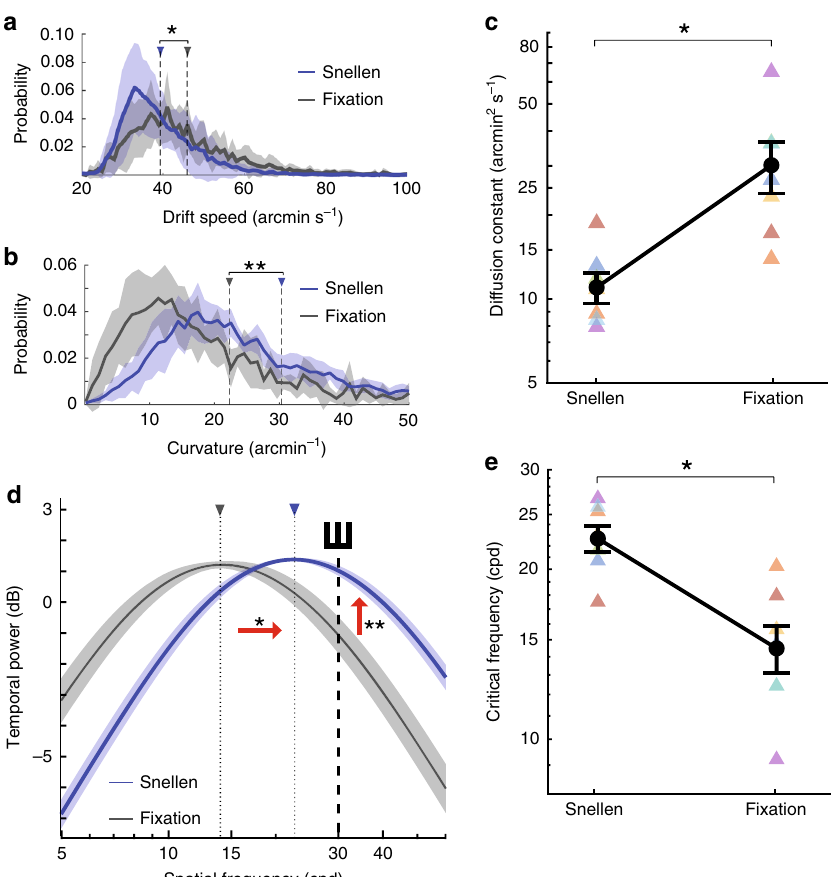
Fig. 2 Drift characteristics. Comparison of oculomotor data collected in the Snellen test and during sustained fi xation. Data represent averages and SEM across N = 7 subjects. a , b Mean distributions of a drift speed and b curvature in the two conditions. Dashed lines indicate the means of the distributions (* p = 0.047, ** p = 0.031, two-tailed Wilcoxon signed-rank test). c Average constants of drift diffusion, D , in the two conditions (* p = 0.035, two-tailed paired t -test). d Average power in the luminance modulations resulting from ocular drift. Power at different temporal frequencies was weighted by the temporal sensitivity of P cells and integrated to estimate the driving input for these neurons. Changes in eye drift shift modulations to higher spatial frequencies (horizontal arrow) amplifying power in the range of the optotypes (dashed line and vertical arrow). Dotted lines with triangles mark the peaks of the distributions (* p = 0.009, two-tailed paired t -test, ** p = 0.022, two-tailed paired t -test). e Changes in the critical spatial frequency, k c , the frequency that delivers the largest luminance modulations (* as in d ). Shaded regions and error bars represent SEM. Triangles in c and e represent data from individual subjects. Source data are provided as a source data fi